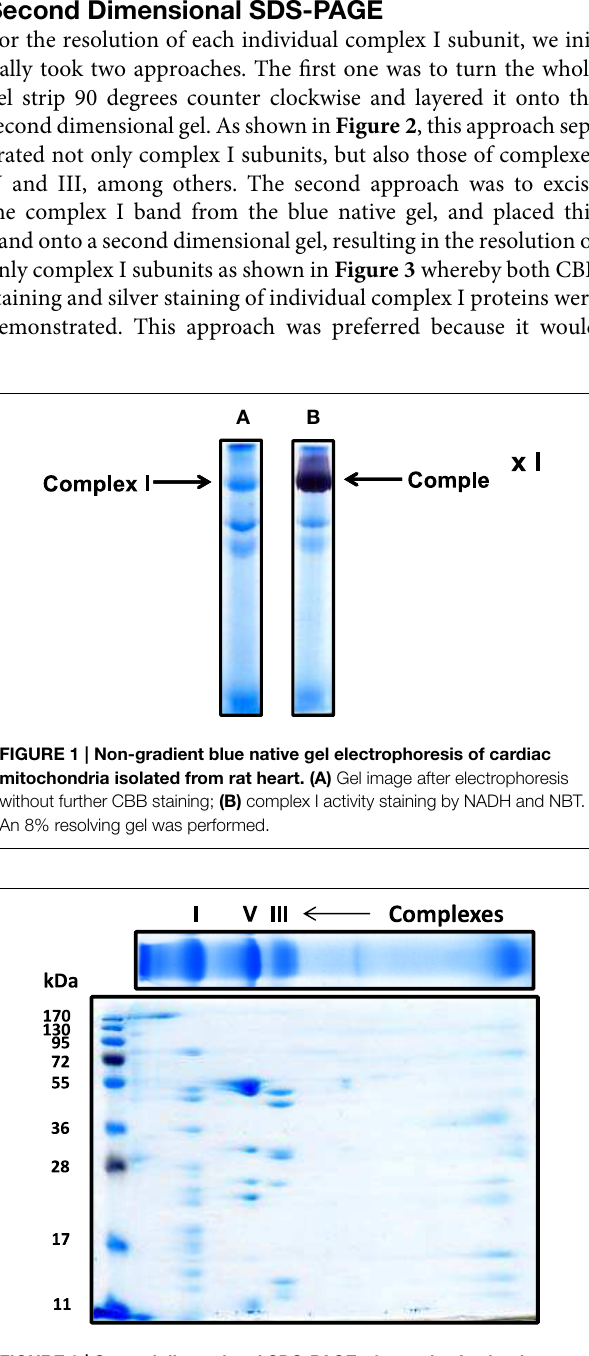
FIGURE 2 | Second dimensional SDS-PAGE of complex I subunits together with those of complex V and complex III. The blue native gel strip was placed on top of the second dimensional SDS gel (10% resolving). Gel was stained by CBB